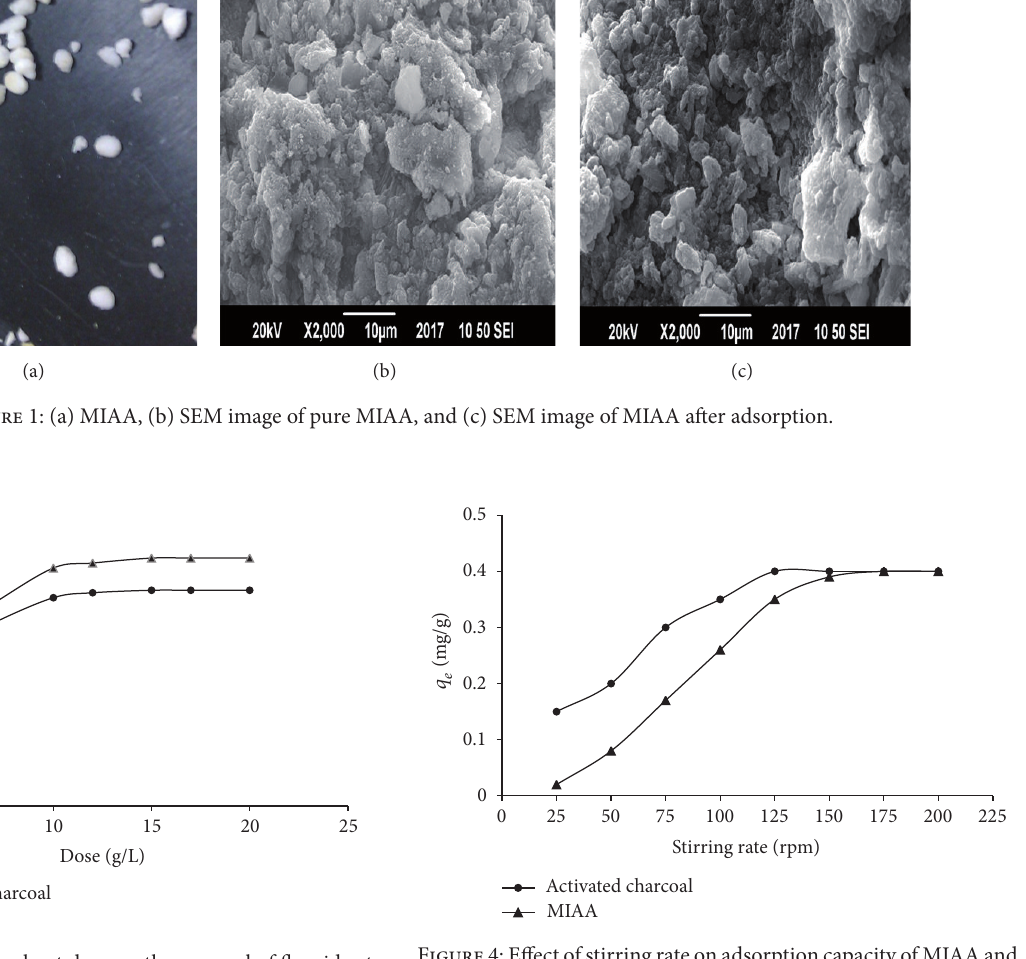
F 2: Effect of an adsorbent dose on the removal of �uoride at